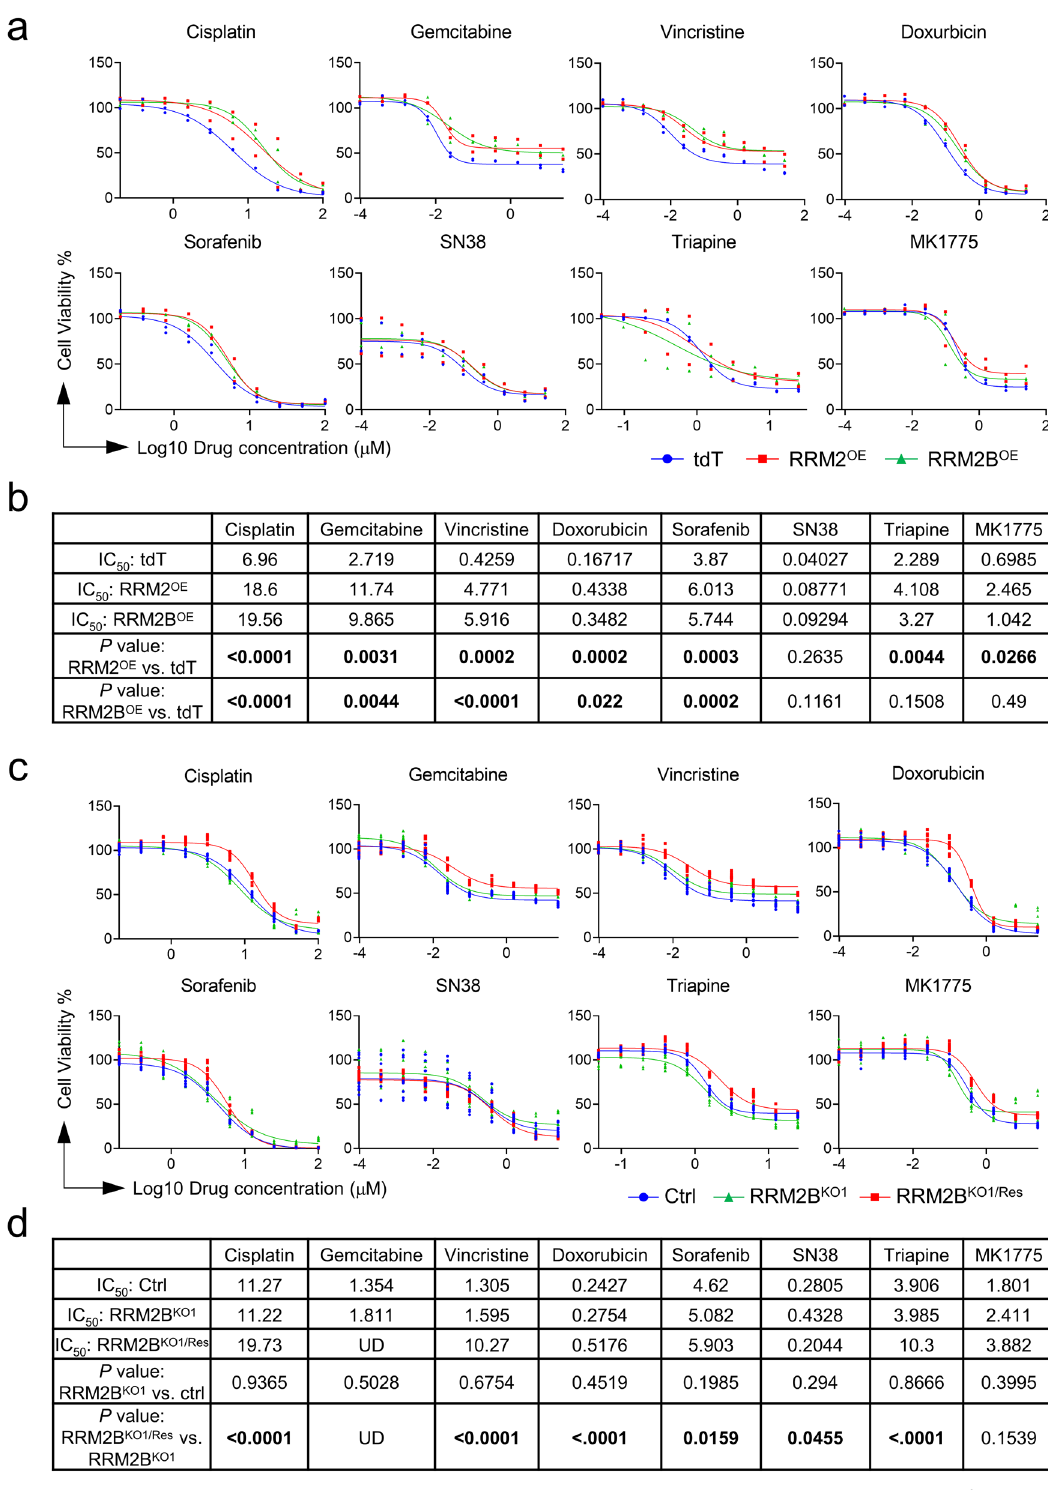
Fig. 5 Both RRM2 and RRM2B contribute moderately to HepG2 cell drug resistance. a The dose-response curves of tdT , RRM2 OE and RRM2B OE HepG2 cells to the indicated drugs ( n = 3 for each group). b List of the drug IC 50 values and their comparisons between tdT , RRM2 OE and RRM2B OE HepG2 cells. c The dose-response curves of control (wildtype), RRM2B KO1 and RRM2B KO1/Res HepG2 cells to the indicated drugs ( n = 3 for each group). d List of the drug IC 50 values and their comparisons between control (wildtype), RRM2B KO1 and RRM2B KO1/Res HepG2 cells. Extra Sum of Square F test was performed for ( b , d ). Statistically signi fi cant P values (<0.05) were indicated by bold